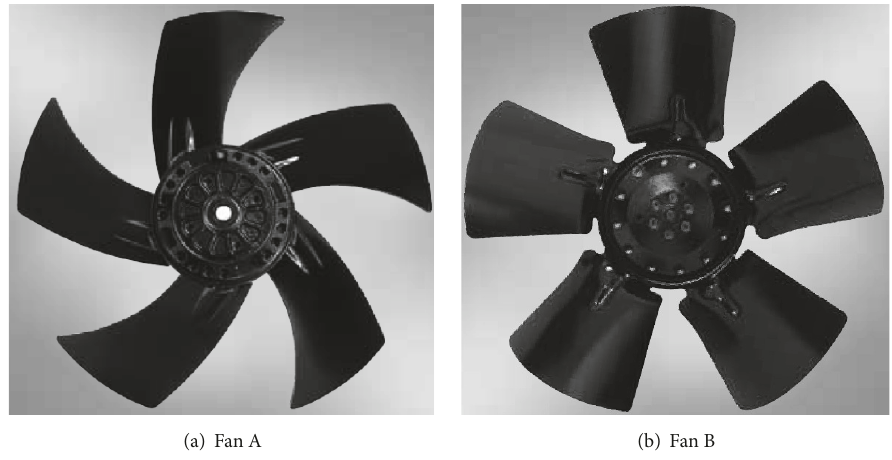
Figure 1: Test fans without shroud and guard grille.